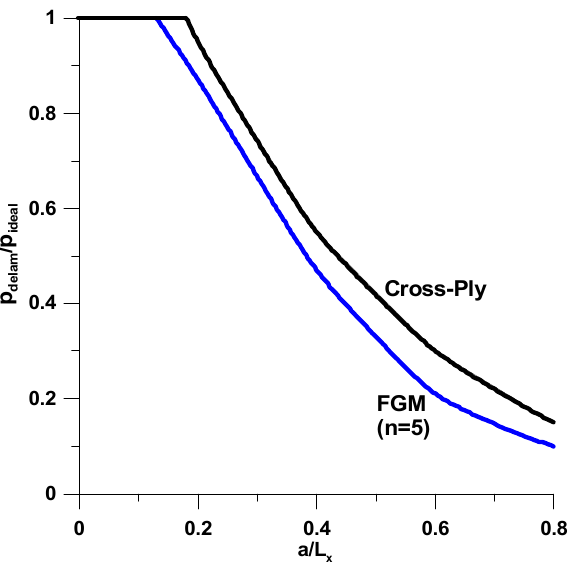
Figure 10. Effects of symmetrical delaminations on buckling loads (h (3) /h (1) = 0.5, the thickness parameter h/L x = 0.02).